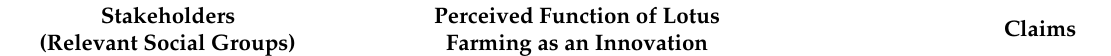
Table 1. Stakeholder Perspectives on Lotus Farming as an Emerging